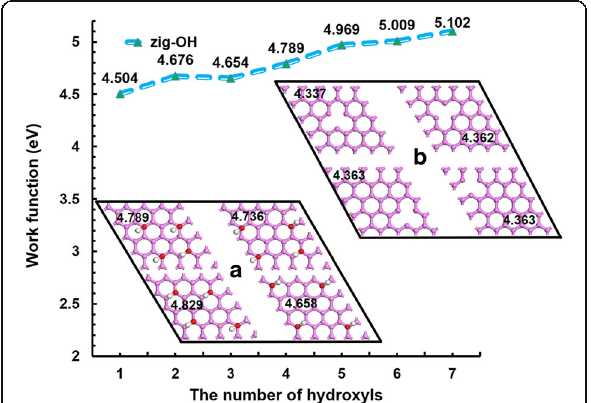
Fig. 3 The relationship between the WF and the number of hydroxyls. The relationship between the WF and the number of hydroxyls; the size of graphene is set at 4×4 supercells. The inset pictures present four different distribution modes of hydroxyls ( a ) and defects ( b